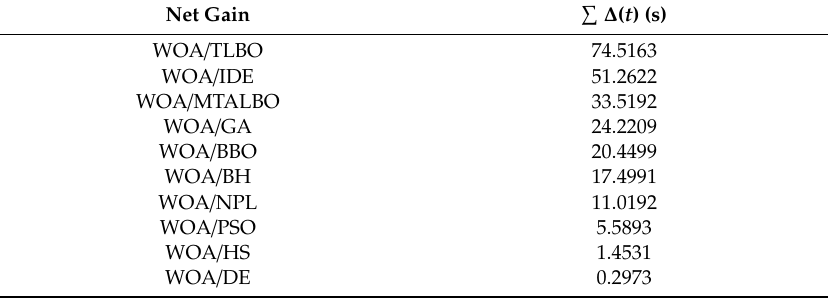
Table 11. Comparison of total net gain in time achieved by the WOA with the methods used in the literature for the IEEE nine-bus